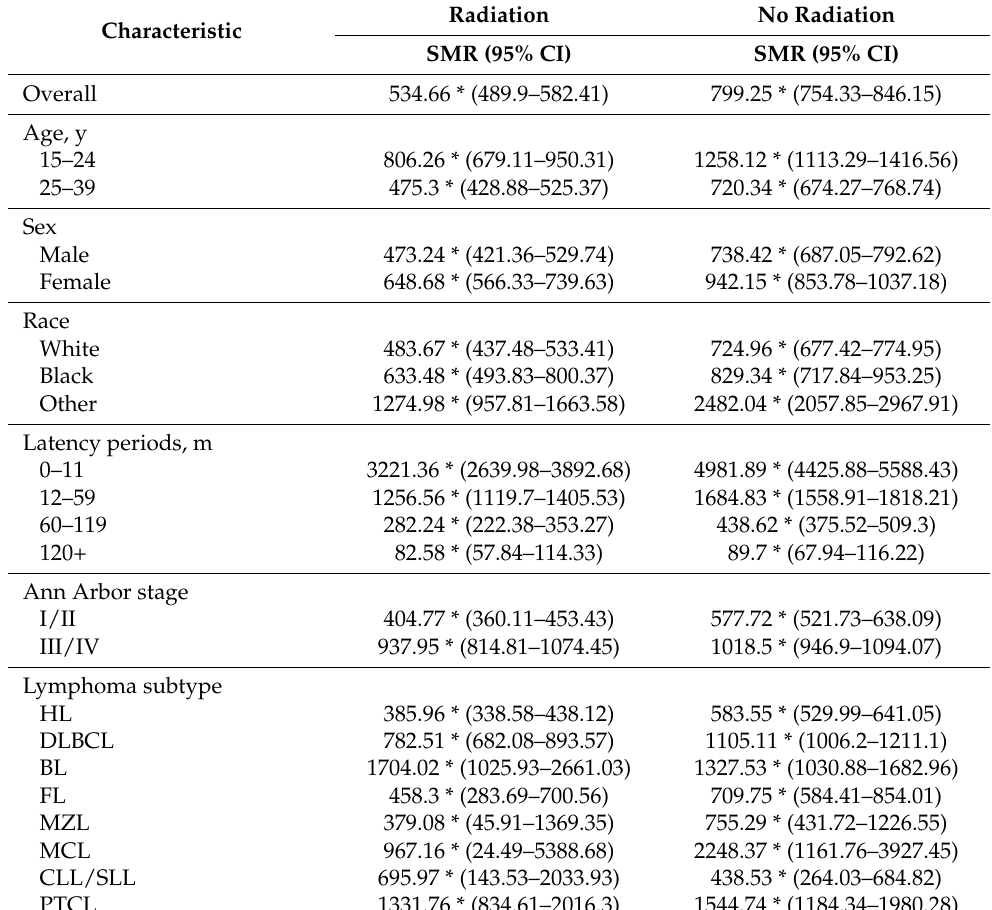
Table 3. Standardized mortality ratios of index-cancer-related mortality among AYA patients accord- ing to baseline